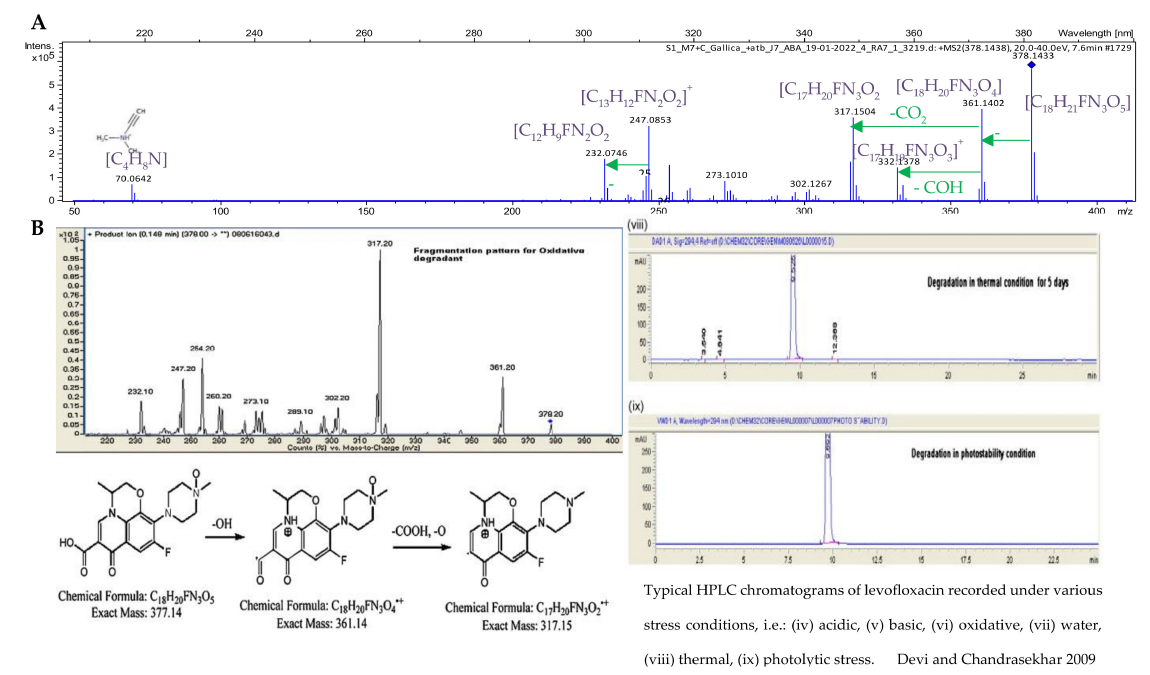
Figure 5. ( A ) Experimental fragmentation pattern of levofloxacin degradation product at 7.6 min ob- tained with Coriolopsis gallica , ( B ) Fragmentation pattern and retention time of N-Oxide Levofloxacin for comparison (reproduced from Devi and Chandrasekhar 2009 with